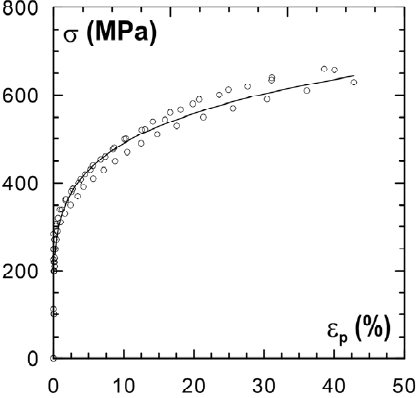
Figure 2. Relationship between engineering stress σ and plastic deformation ε p . Table 1. Chemical composition of X2CrNi18-9 steel (% by mass).